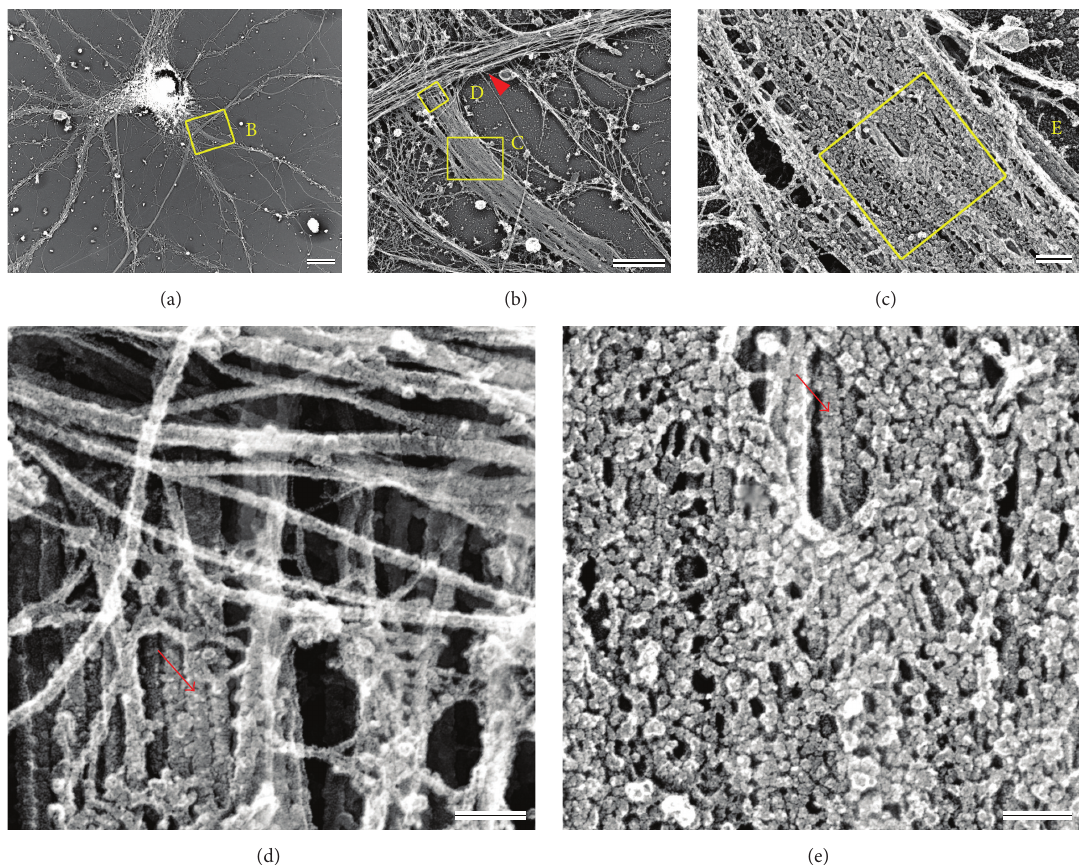
Figure 2: Platinum replica electron microcopy (PREM) revealing axon initial segment (AIS) structure of 21 DIV hippocampal neuron. (a) A neuron with dendrites and an axon (box B) extending from the soma. (b) Enlargement of box B in (a) showing a segment of the AIS (box C) and a portion of the axon hillock (box D), a region of the neuron that connects the soma and axon. The axon hillock is largely covered by an axon or dendrite (arrow head) from a different neuron. (c) Enlargement of box C in (b). (d) Enlargement of box D in (b) showing a microtubulefascicle(arrow)intheaxonhillockthatappearstoentertheAIS.Mostofthemicrotubulesintheaxonhillockarenonfasciculated. (e) Enlargement of box E in (c) showing a dense coat of globular and fibrillary structures. This coat corresponds to two upper layers of the AIS cytoskeleton, the immobilized plasma membrane proteins and submembrane cytoskeleton. Many of the globular structures in the coat correspond to voltage-gated ion channels and AnkG bound to its interaction partners. The fibrils represent cell adhesion molecules (CAMs), 𝛽 IV-spectrin, and some AnkG molecules lacking interacting proteins. A microtubule fascicle can be seen in an opening of the coat where globules and fibrils are lacking (arrow). Note that such occasional openings in the AIS coat create small windows through which the inner AIS shaft can be seen (see Figure 1(a)). Bars: (a) 10 𝜇 m; (b) 2 𝜇 m: (c) 200 nm; (d) 100 nm; (e)